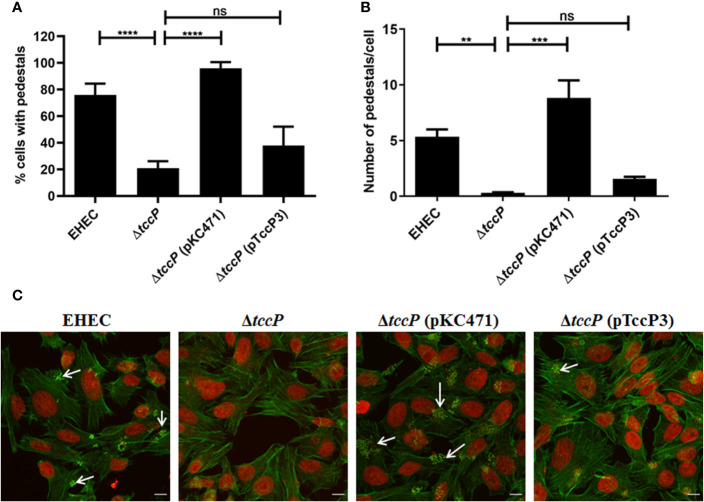
Evaluation of the efficiency in F-actin polymerization in HeLa cells due to TccP3 production in the EHECΔtccP background. The efficiency of the TccP3 produced by E. albertii 1551-2 strain to promote F-actin aggregation was evaluated by quantitative assays to determine the percentage (%) of cell-associated bacteria with intense F-actin staining (A) and number of sites of F-actin staining in epithelial cells (B) infected with the strains: O157:H7 EHEC 86-24, EHEC 86-24ΔtccP, EHEC 86-24ΔtccP (pKC471), and EHEC 86-24ΔtccP (pTccP3). Representative images used in quantitative fluorescence actin staining (FAS) assays are shown in panel (C) and arrowheads indicate intense F-actin staining. These data demonstrate that TccP3 does not restore the efficiency of the EHEC 86-24 strain to promote F-actin accumulation underneath adherent bacteria. **p < 0.01 and ***p < 0.001, and ns: not significant. Scale bar = 10 μm.